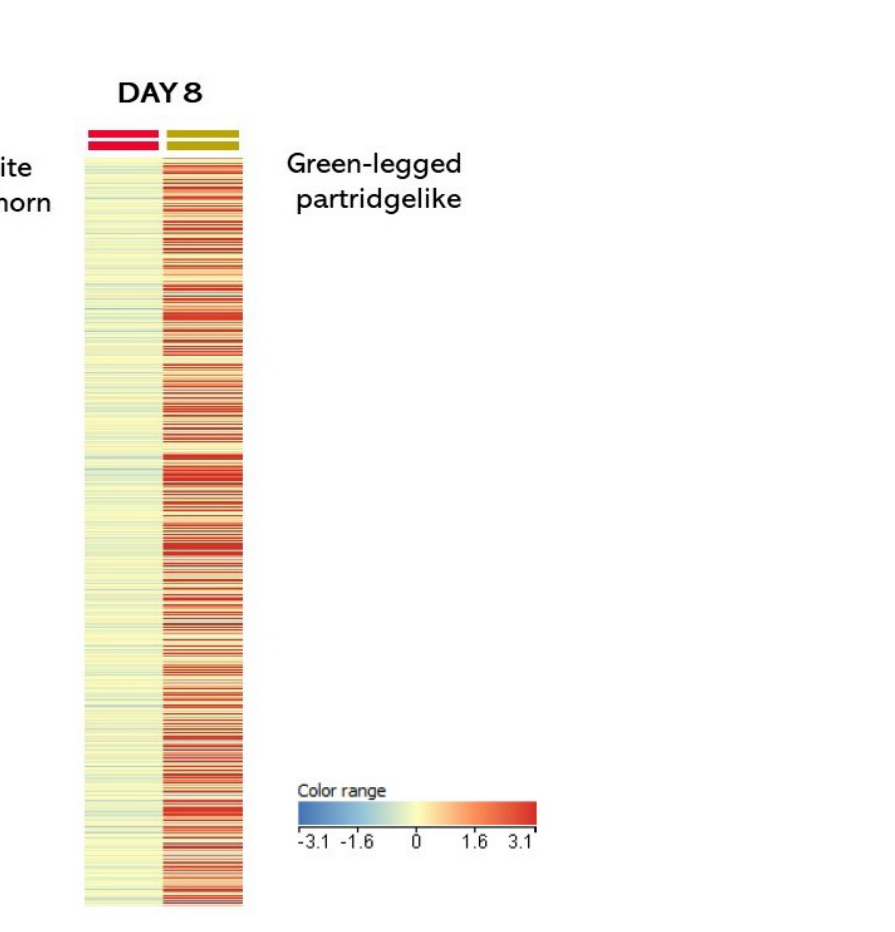
Figure 4. Heat maps of statistically significant differences in gene expression between two genotypes (comparison of GP to White Leghorn (WL)) on day 8 of embryonic development.